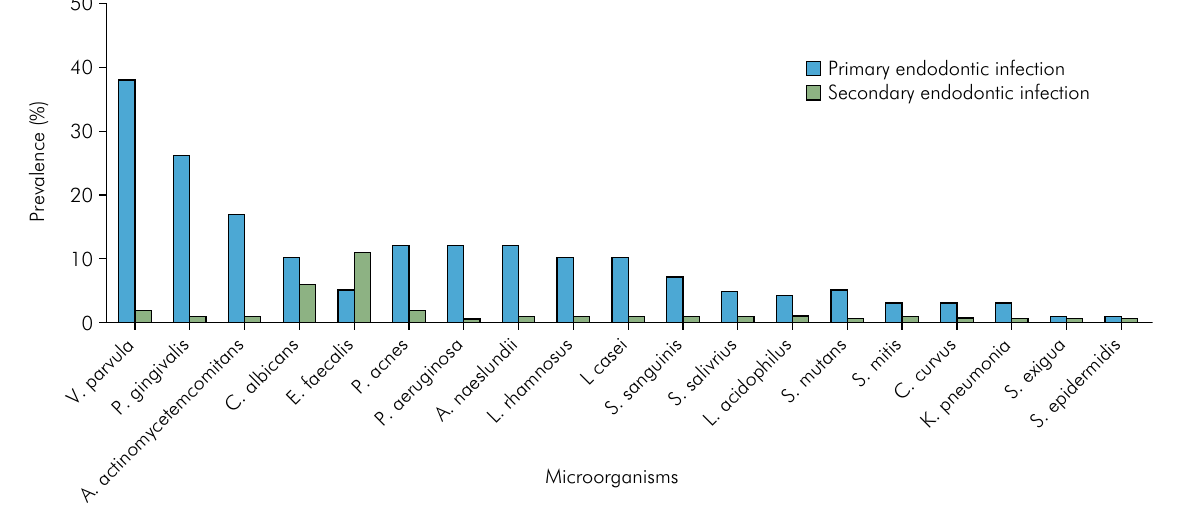
Figure 1. The distribution of microorganisms isolated from patients with primary and secondary endodontic infections.